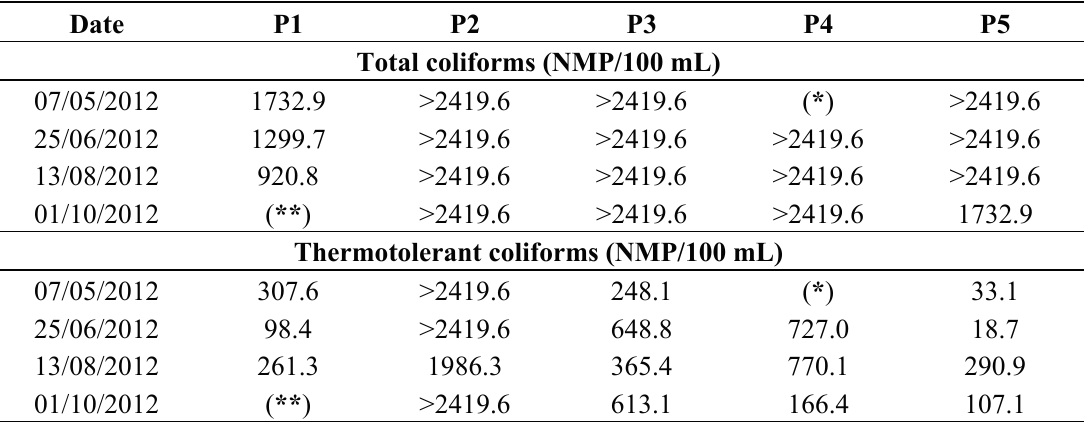
Table 3. Results of the biological parameters in the surface water at the headwaters of the Preto River, Formosa,